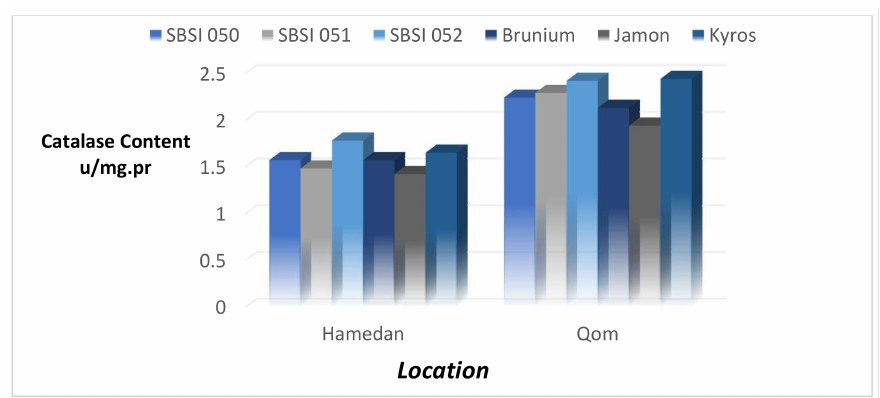
Figure 9. The interaction effect of location × genotype on catalase content. Table 6. Mean comparison of the interaction effects of methanol × glycine betaine × genotype on the evaluated